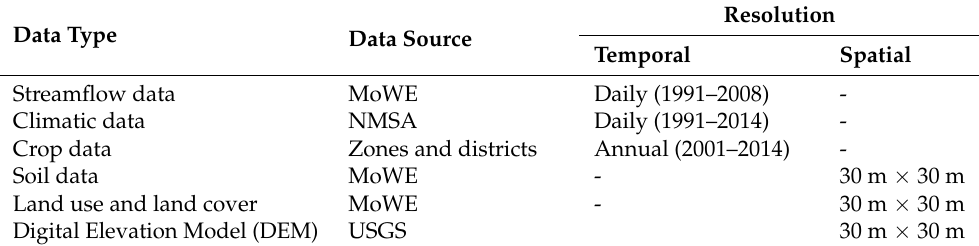
Table 1. Collected data .